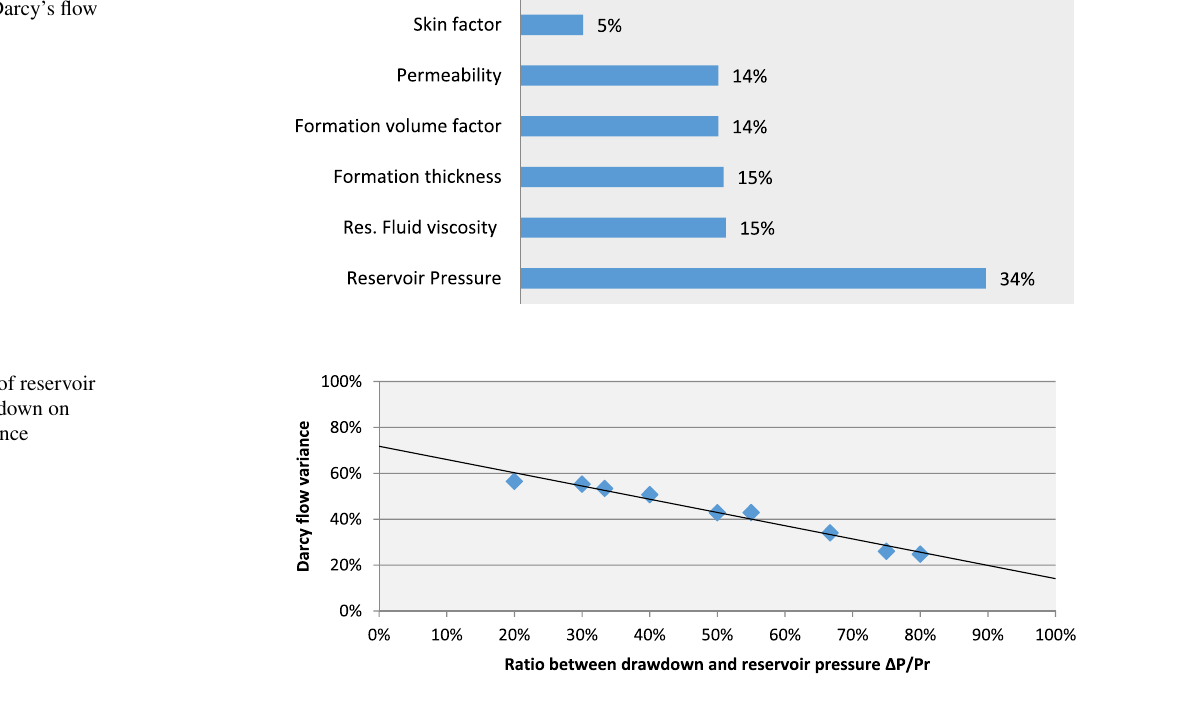
Fig. 5 VBSA on Darcy’s flow